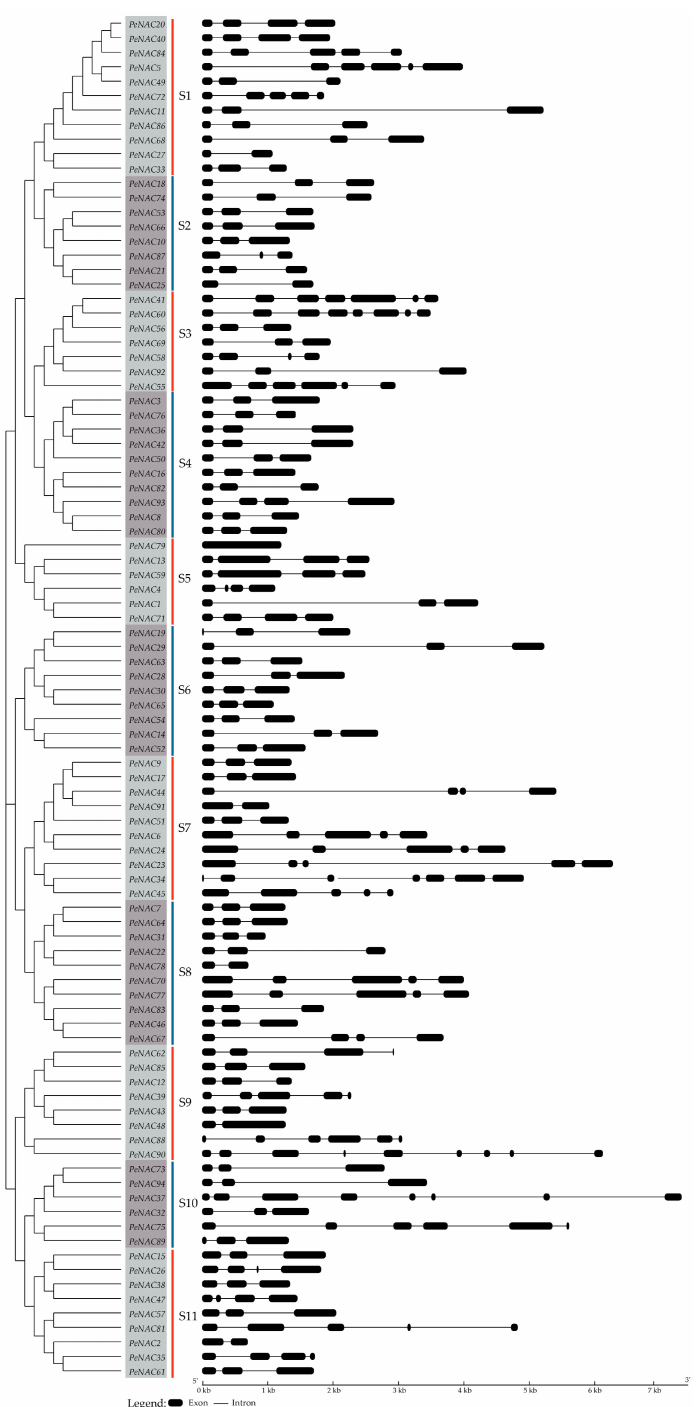
Figure 1. Exon–intron structures of PeNAC s in moso bamboo. The black boxes represented exons and spaces between the black boxes corresponded to